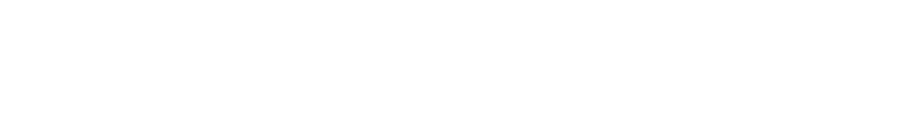
Frontiers in Psychiatry | Addictive Disorders and Behavioral